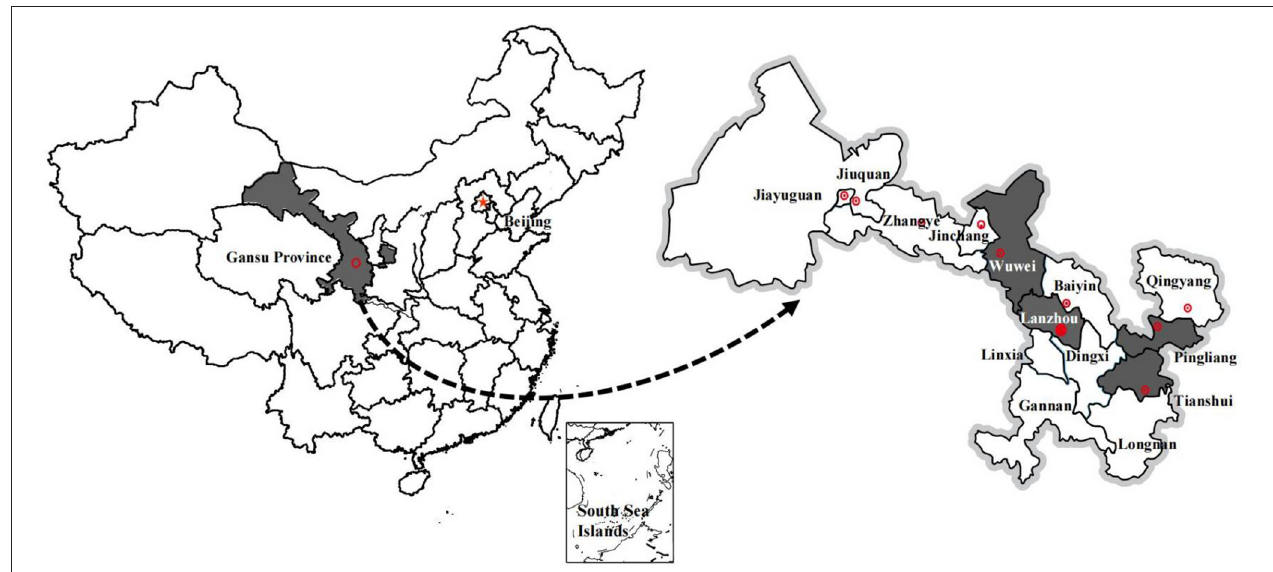
FIGURE 1 | The regional distribution of sample cities in Gansu